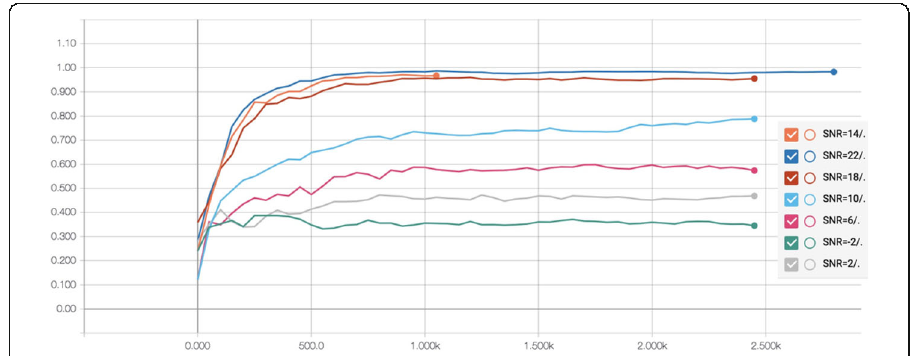
Fig. 20 Classification accuracy change under different SNRs